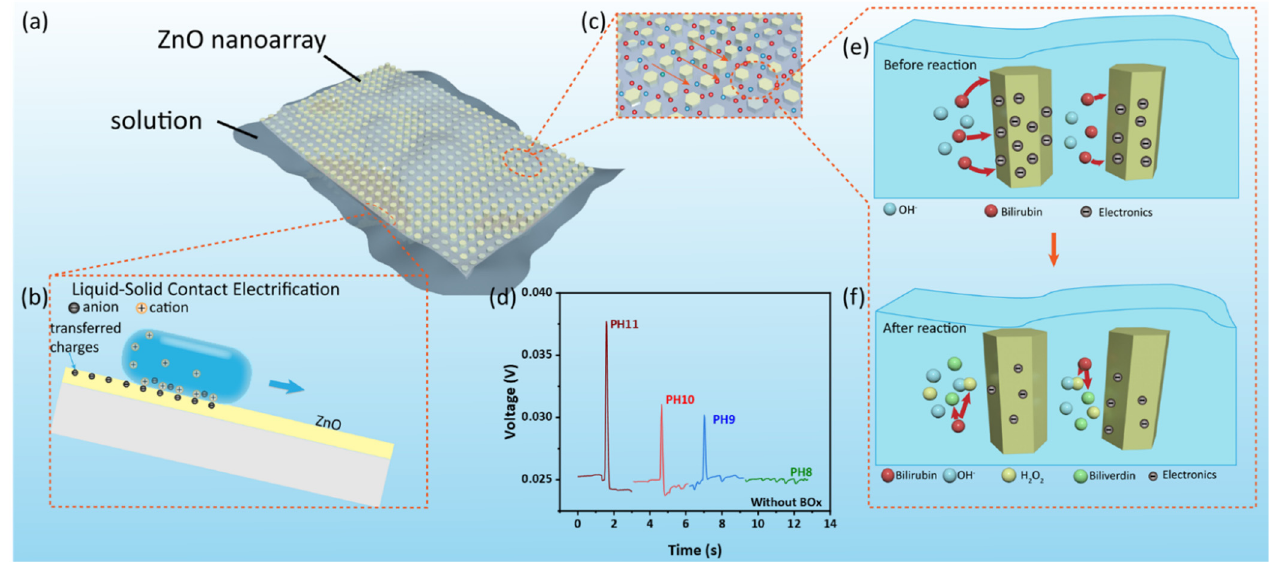
Figure 3. The working mechanism of the self-powered wearable biosensor. ( a , b ) The power gener- ating process. ( c ) Molecular flowing along ZnO nanowire. ( d ) The output voltage of the device in different pH value aqueous solution. ( e , f ) The biosensing process for detecting bilirubin.